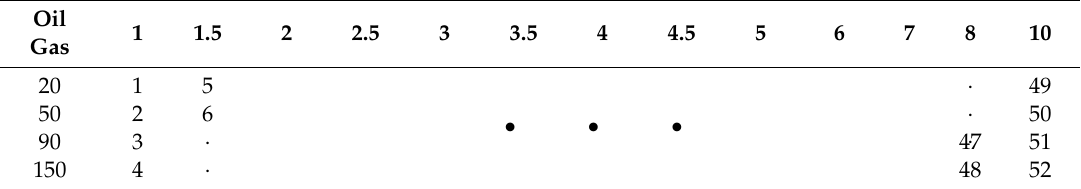
Table 1. Working condition distribution table m 3 /h.